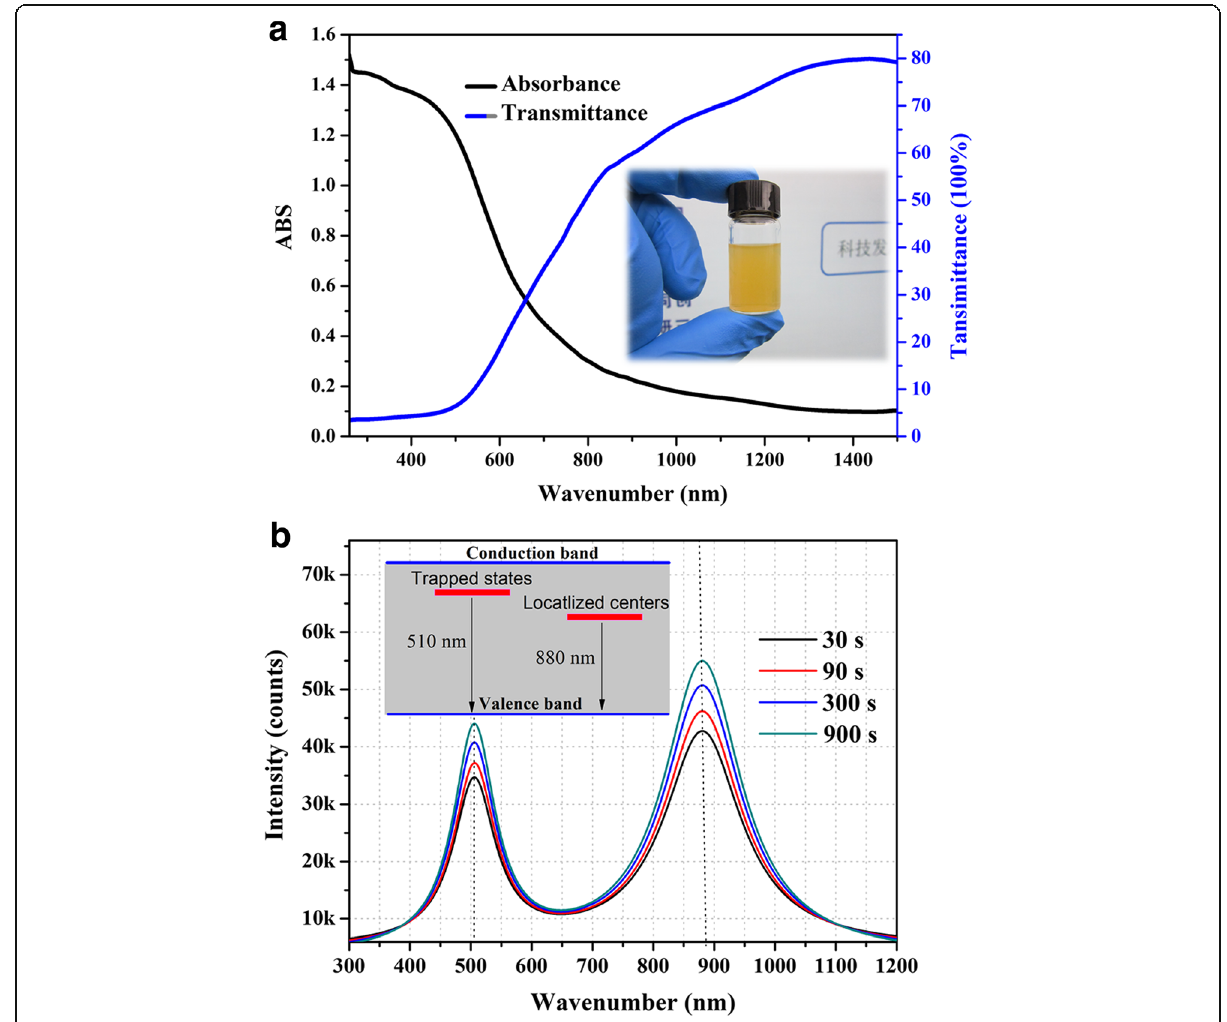
Fig. 2 Optical properties of Sb 2 S 3 QD dispersion. a Absorbance and b PL spectrum of Sb 2 S 3 dispersion